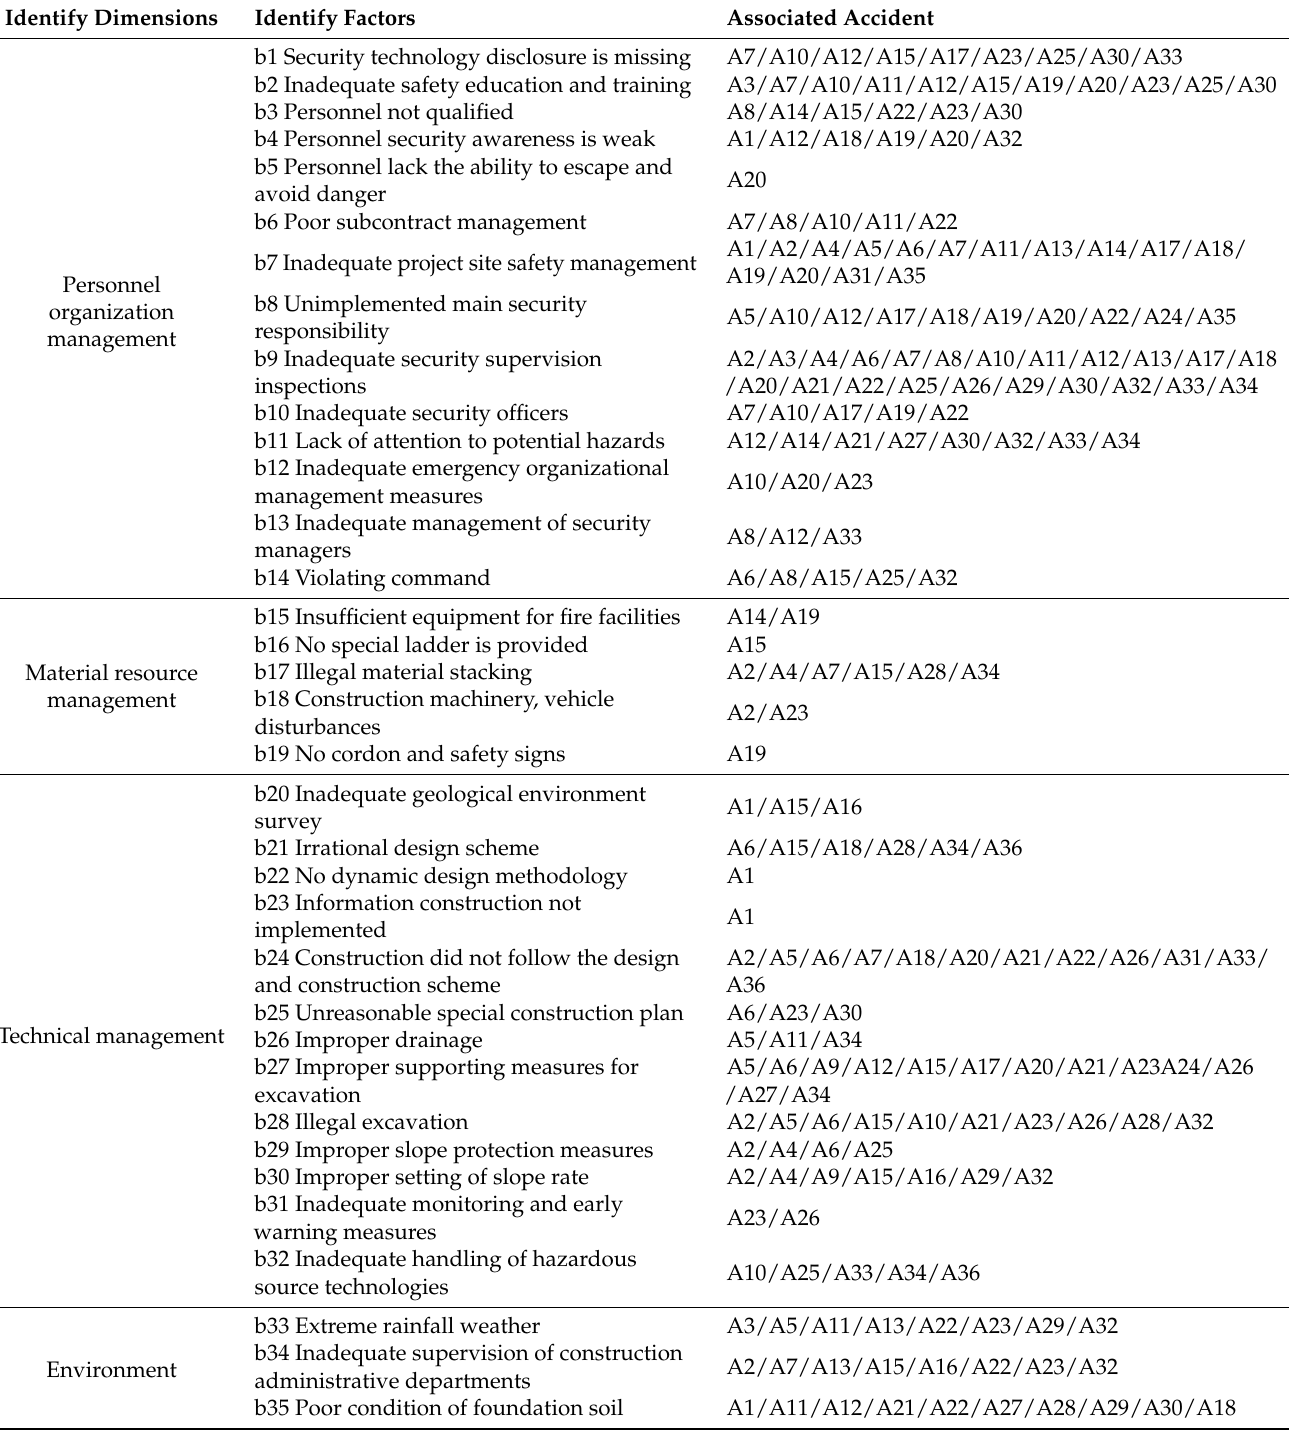
Table 1. Resilience influencing factors based on the causal summary of typical accident